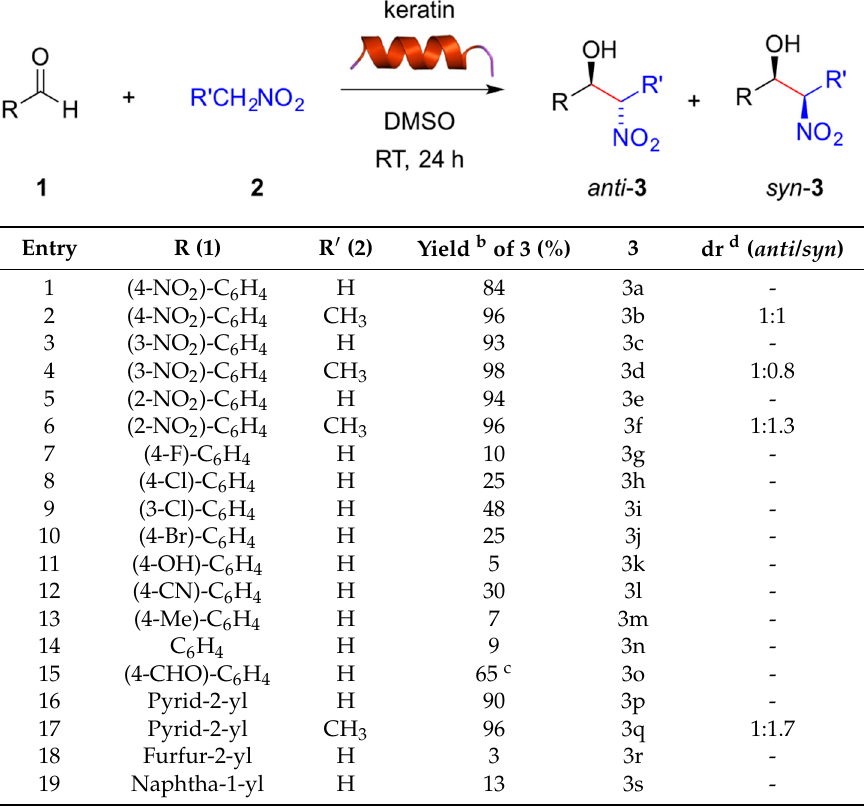
Table 2. Keratin-catalyzed nitroaldol (Henry) reaction in DMSO a .